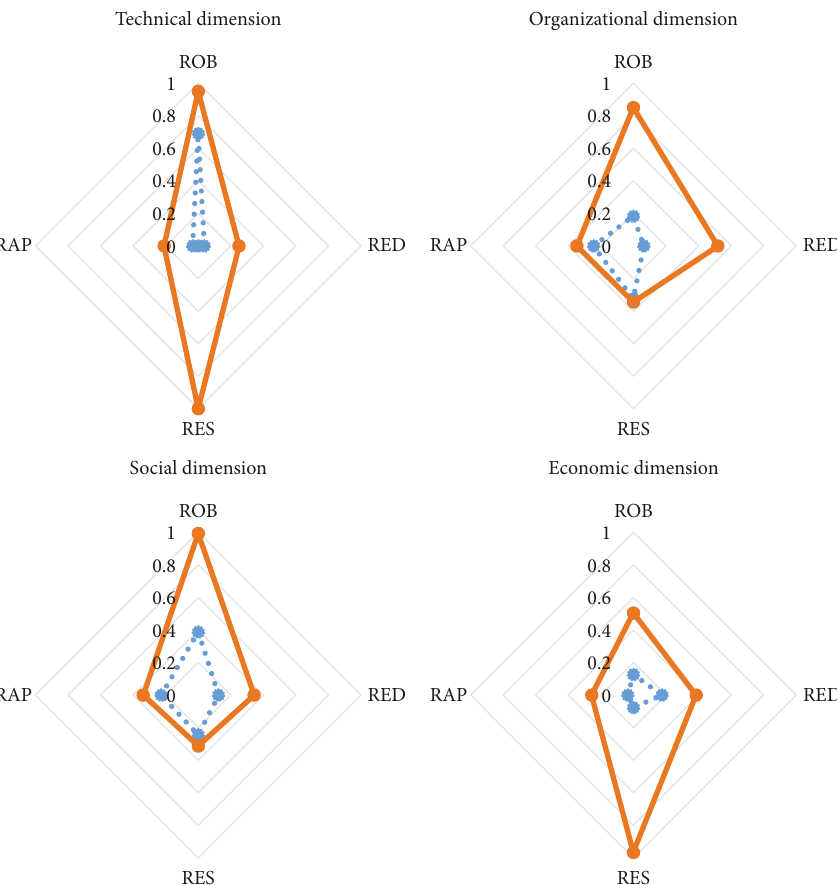
Figure 5: Spider graph showing the values of speci fi c components of resilience according to the metrics de fi ned in Table 12, referring to scenario